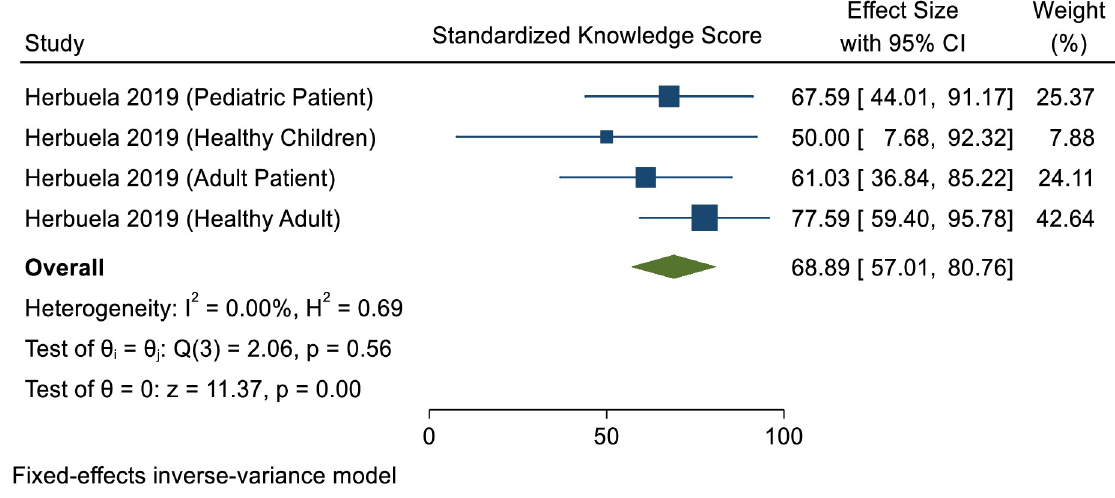
Fig 2. Meta-analysis of dengue knowledge scores in the